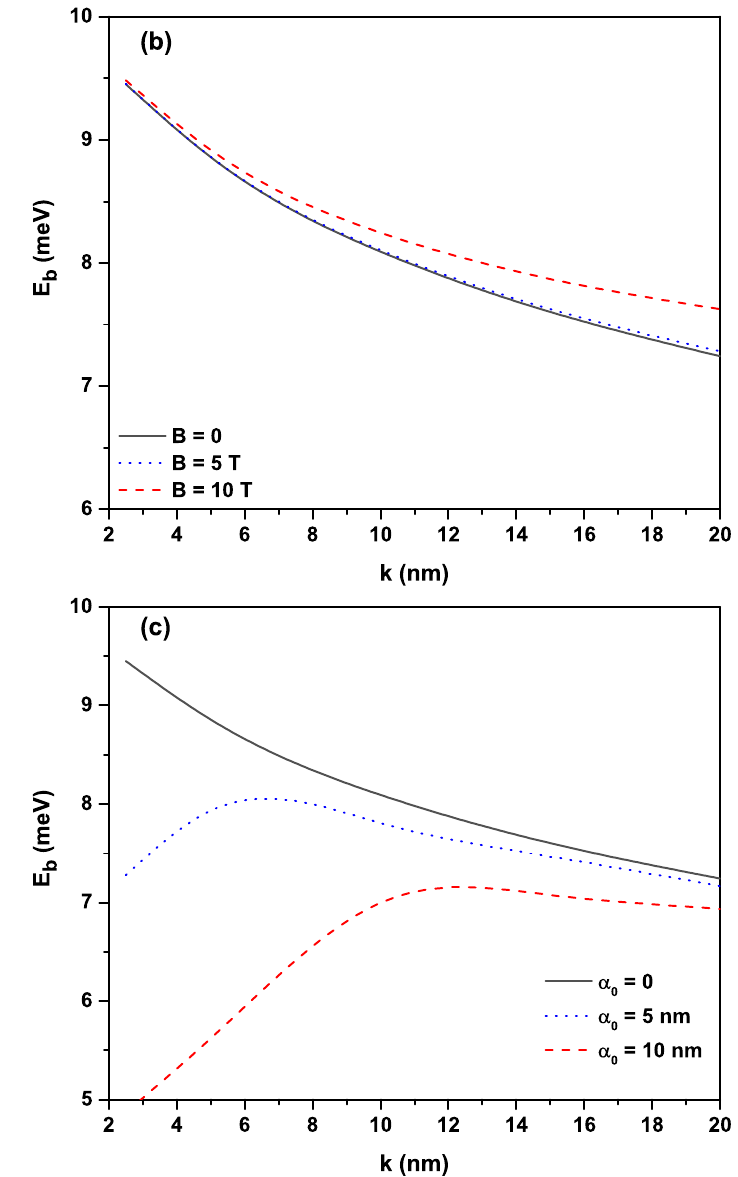
Figure 2. Heavy-hole exciton binding energy as a function of the well width parameter for confine- ( h ) ν 2 tanh 2 ( z / k ) in the presence of the external fields: ( a ) electric ment potential V 2 ( z e ( h ) ) = − V e 0 field ( B = 0 and α 0 = 0), ( b ) magnetic field ( F = 0 and α 0 = 0), and ( c ) intense laser field ( F = 0 and B = 0), respectively. The insets are not provided here because they are the same as in Figure 1a–c. Results are for ν 2 = −